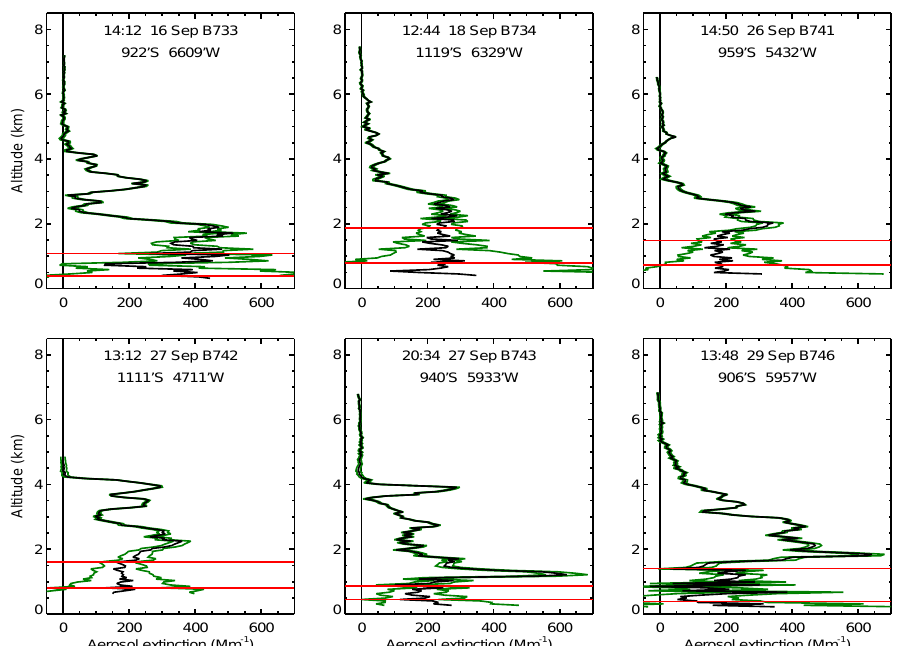
Figure 4. A sample of the lidar vertical profiles of aerosol extinction coefficient, discussed in this paper. The green lines indicate the estimate of uncertainty. The red lines indicate the reference height interval used (different for each profile). The time, date, flight number and coordinates are indicated in the title to each plot. Each profile corresponds to an integration time of